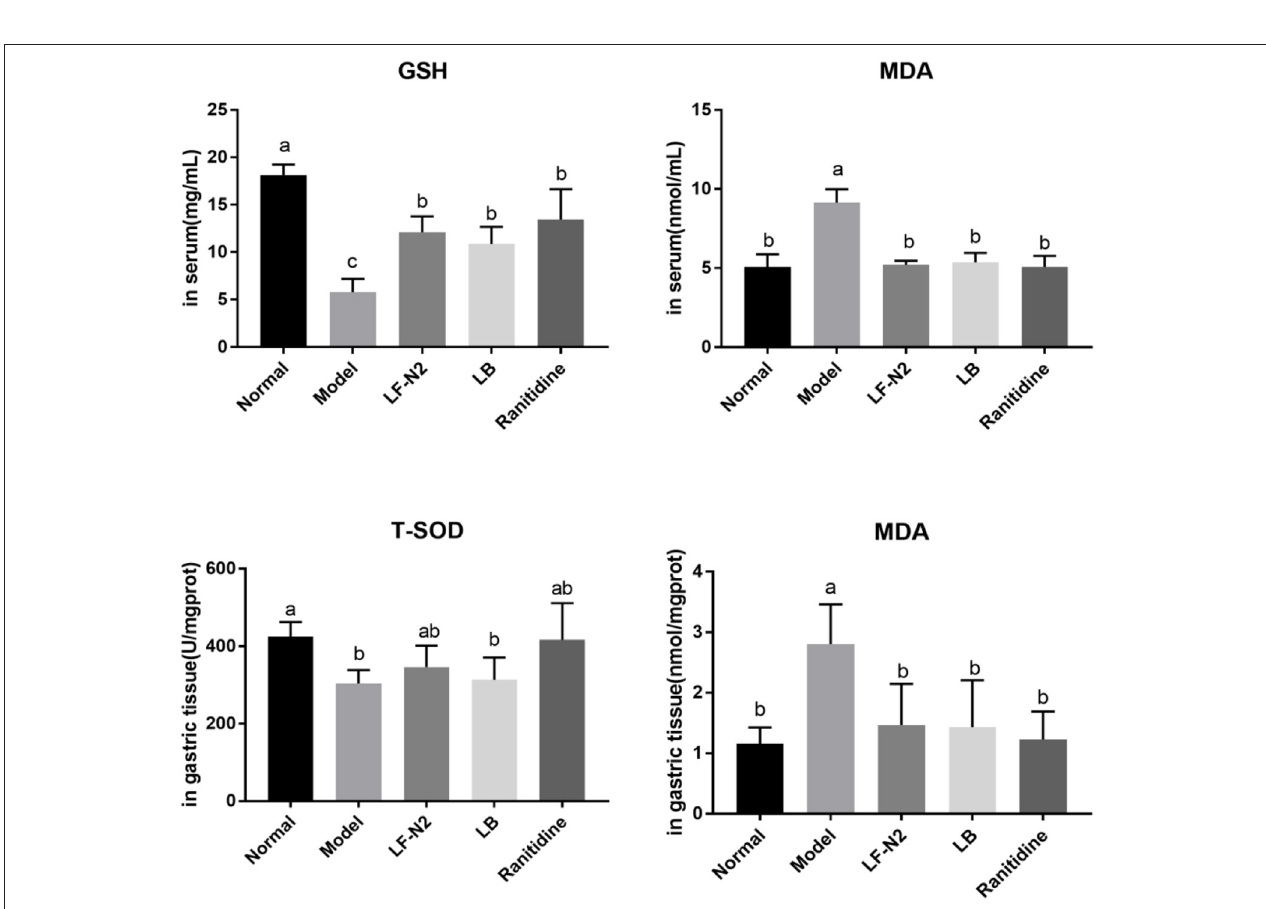
FIGURE 3 | Levels of antioxidant factors in serum and gastric tissue, ( n = 6). LF-N2, Lactobacillus fermentum TKSN02 (1 × 10 9 CFU//kg); LB, Lactobacillus bulgaricus (1 × 10 9 CFU/kg); ranitidine (200 µ g/g). a − c Mean values with different letters in the same bars are significantly different ( P < 0.05).